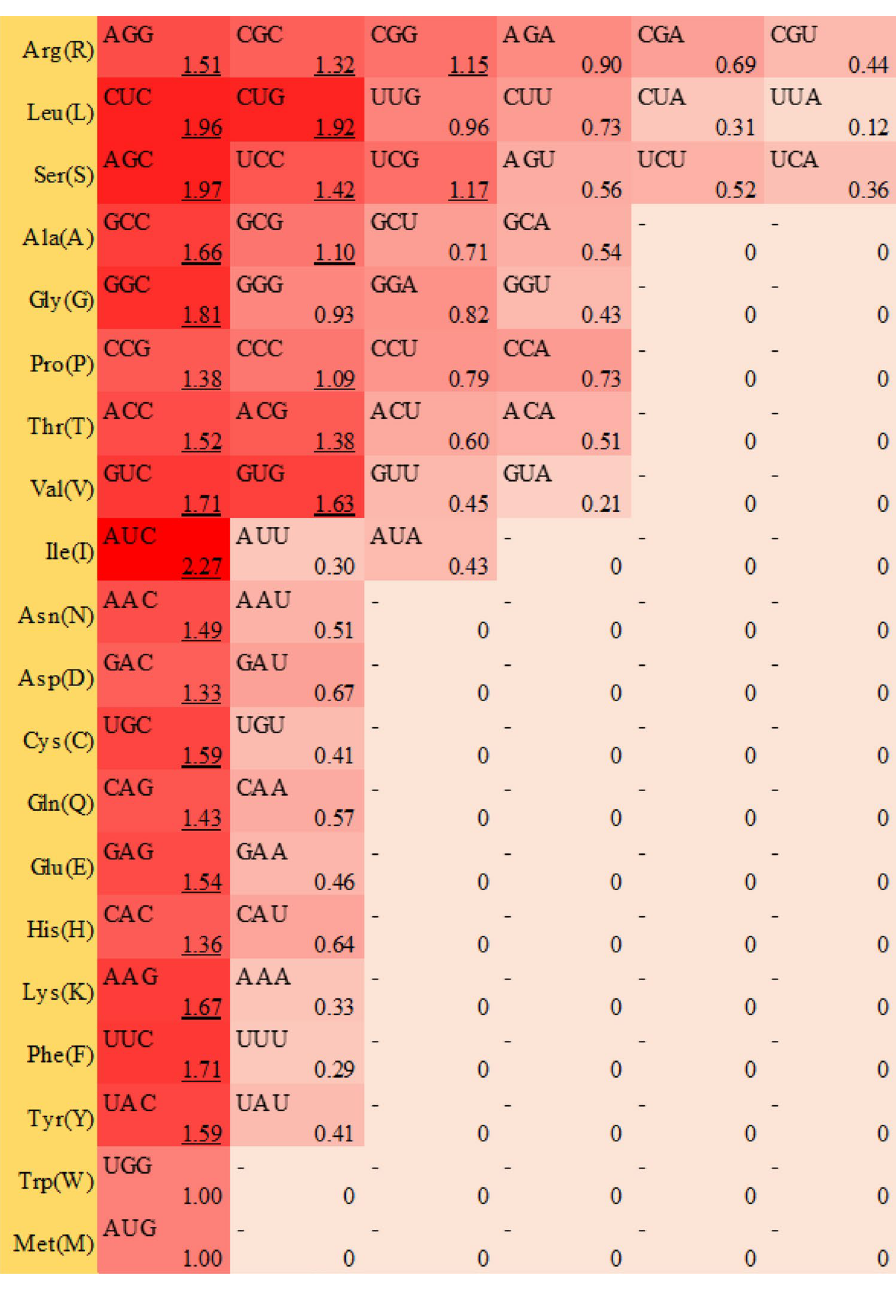
Figure 8. Relative usage of synonymous codons in MaLOX gene family members. The underlined data indicate that the MaLOX genes preferentially to use this